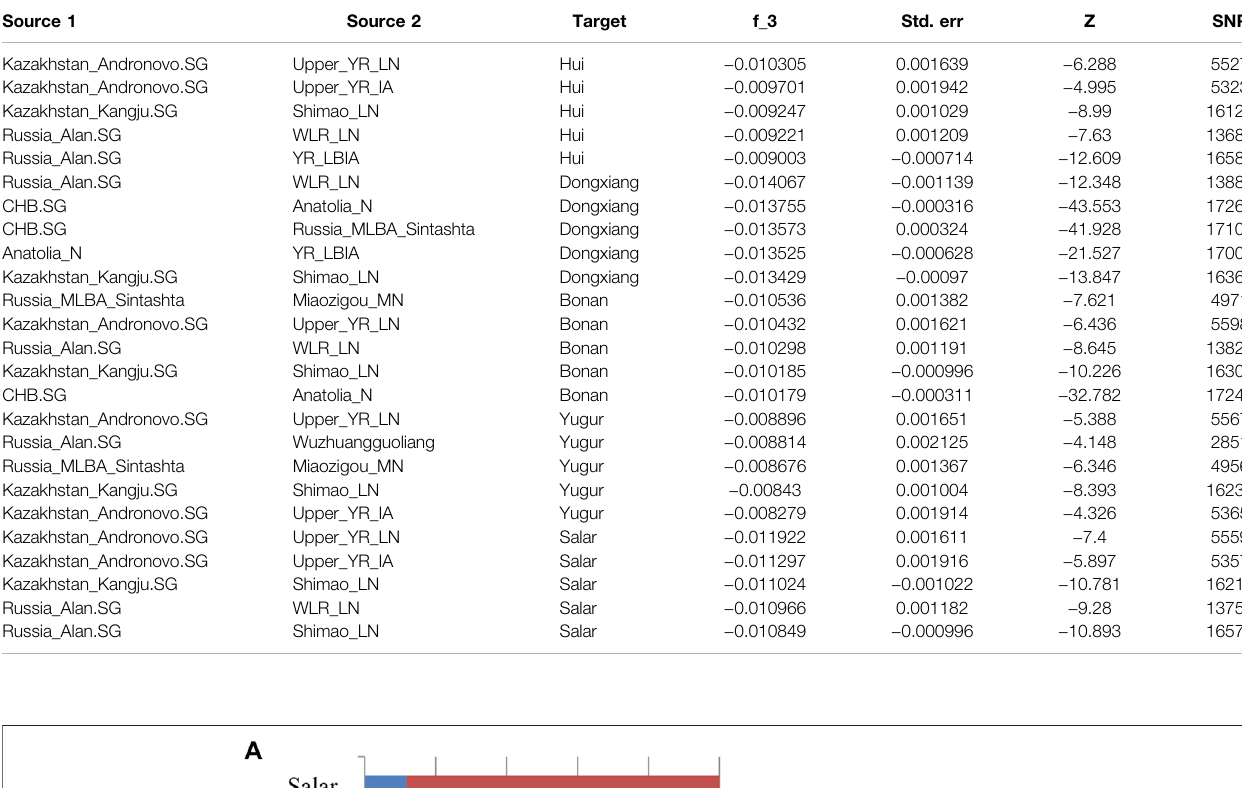
TABLE 1 | Admixture f3 statistics of the form (Source1, Source2; Target) with the lowest f3 values. Source 1 Kazakhstan_Andronovo.SG